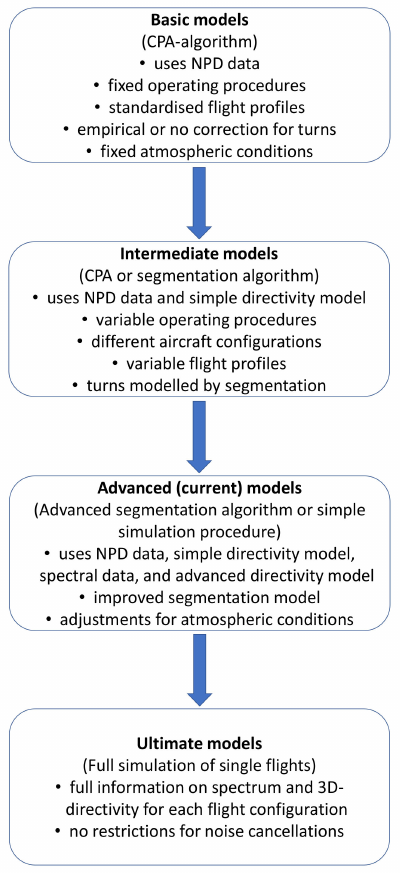
Figure 1. Traditional aircraft noise modelling approach. Adapted from